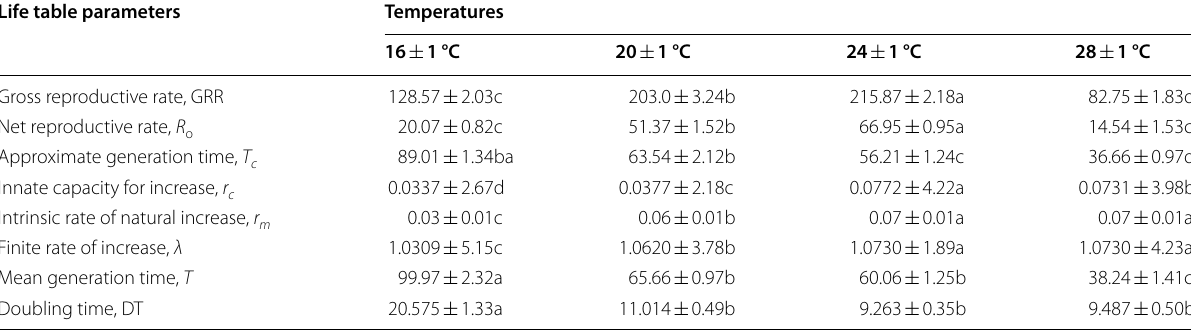
Means within the rows with different lowercase letters are significantly different from each other at P value